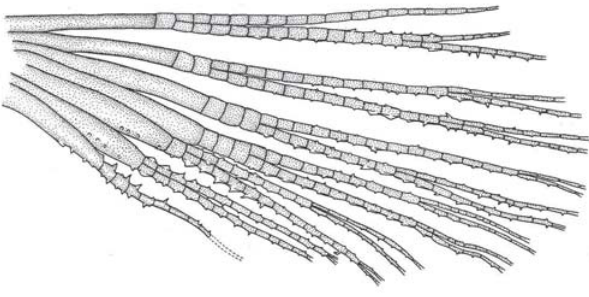
Fig. 27. Glandulocauda caerulea , adult male, USNM 326756, 39.4 mm SL; pelvic-fin rays, ventral view, left side.